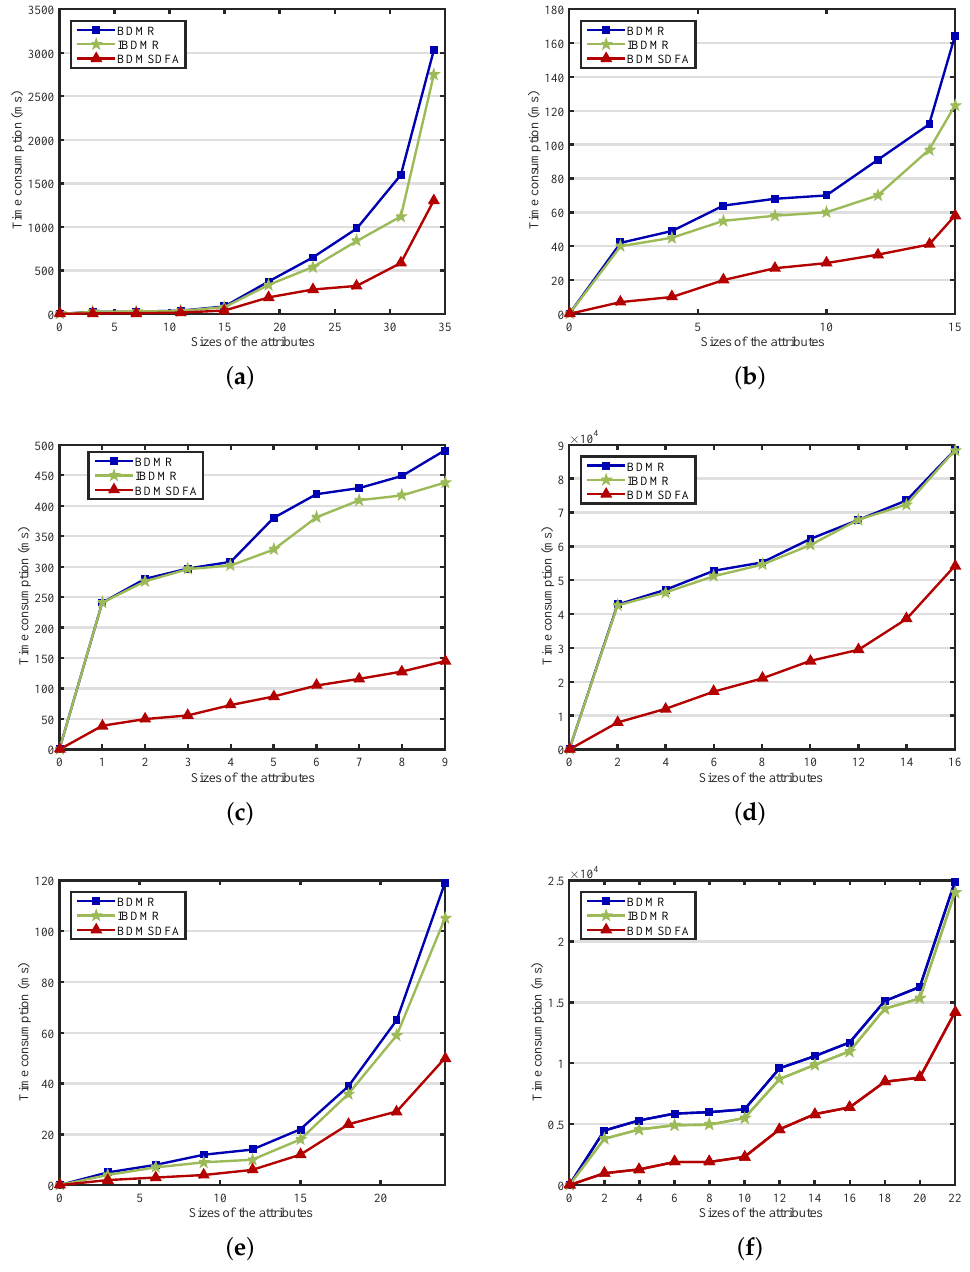
Figure 8. ( a ) Dermatlogy; ( b ) Credit_a; ( c ) Controceptive_Method_Choice; ( d ) Letter; ( e ) Flag; ( f )